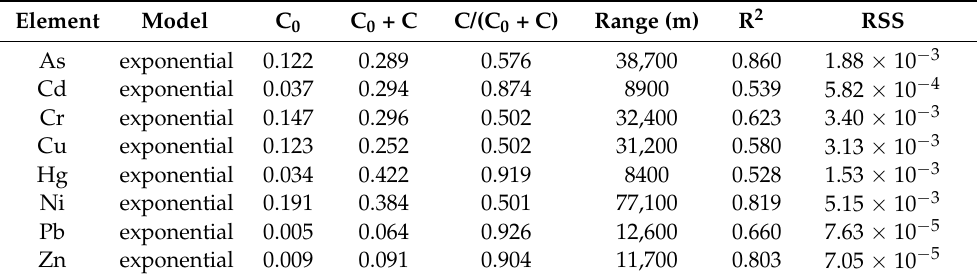
Table 3. Parameters of the semi-variogram models for heavy metals in farmland soil. Element Model As